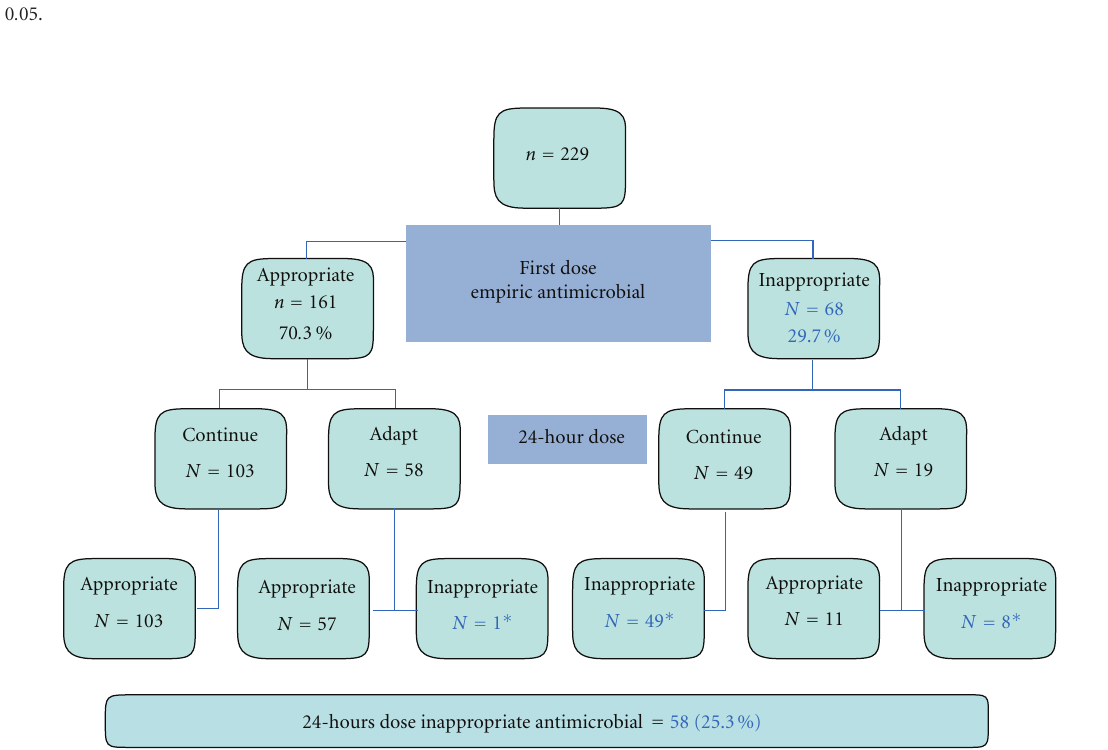
Figure 1: Number and percentage of inappropriate empiric antimicrobial therapy at first dose and subsequent adaptation at 24 hours (Cont; Continuation of Empiric Antimicrobial Therapy, Adapt; Adaptation of Empiric Antimicrobial